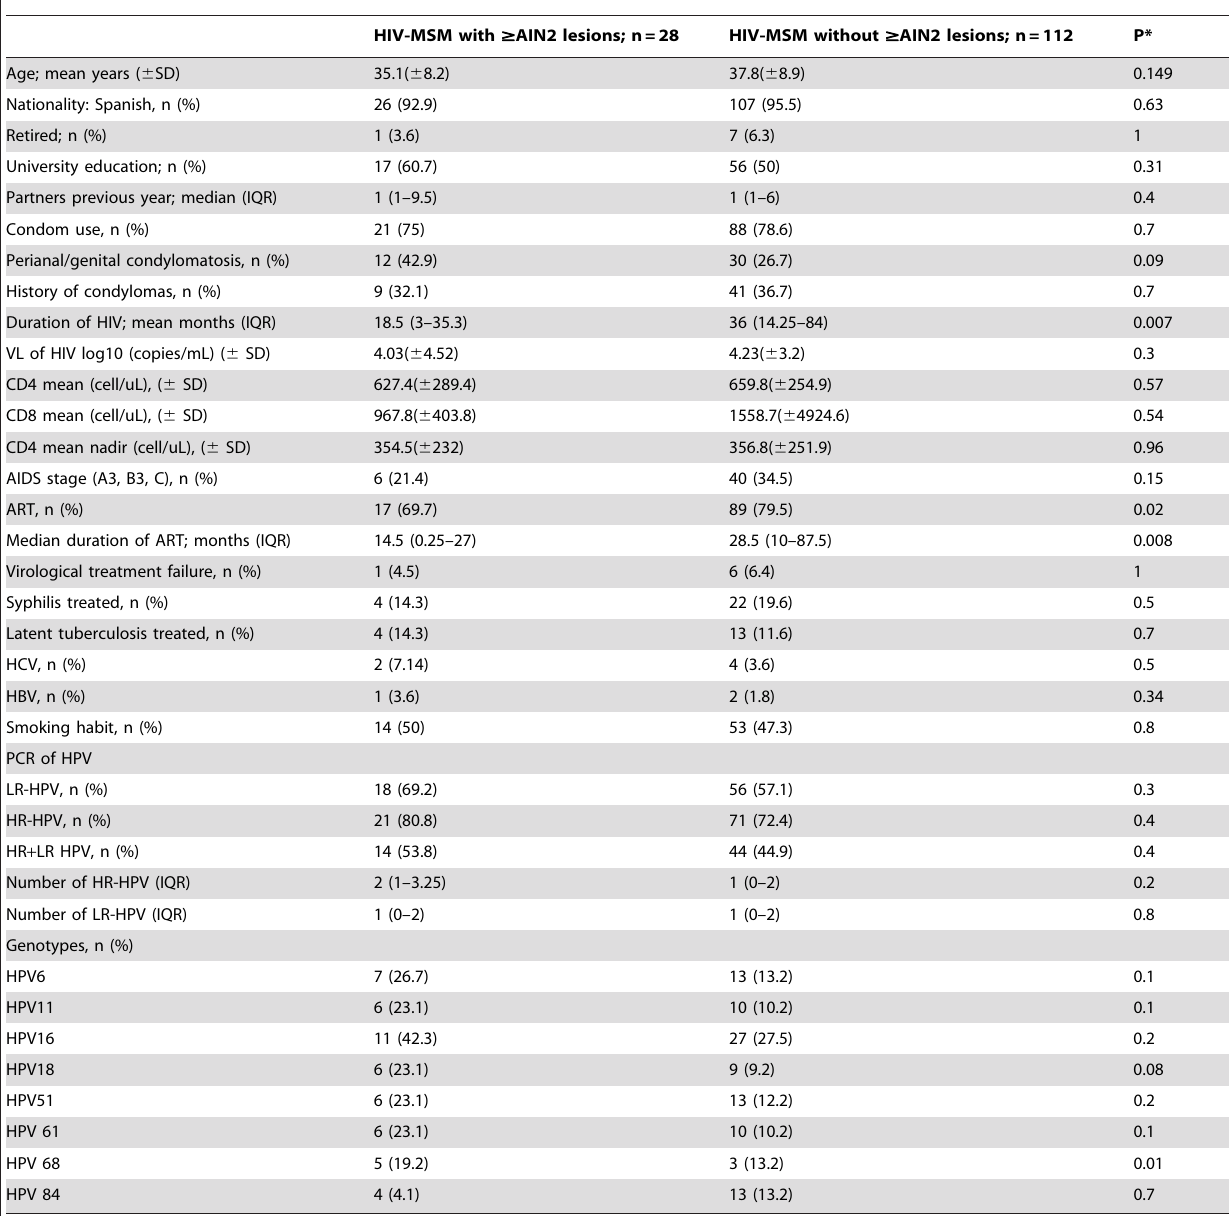
Table 4. Risk factors associated with the appearance of lesions $ AIN2. Univariate